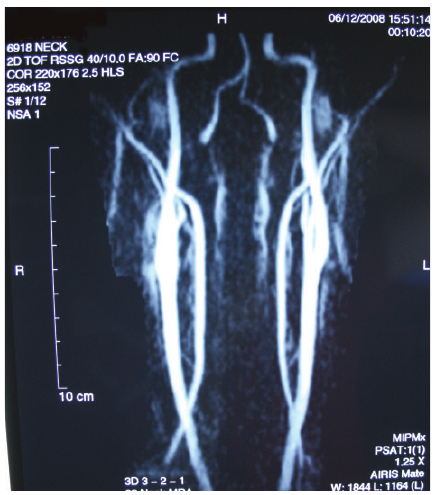
Figure 7: Magnetic resonance angiography showing normal carotid